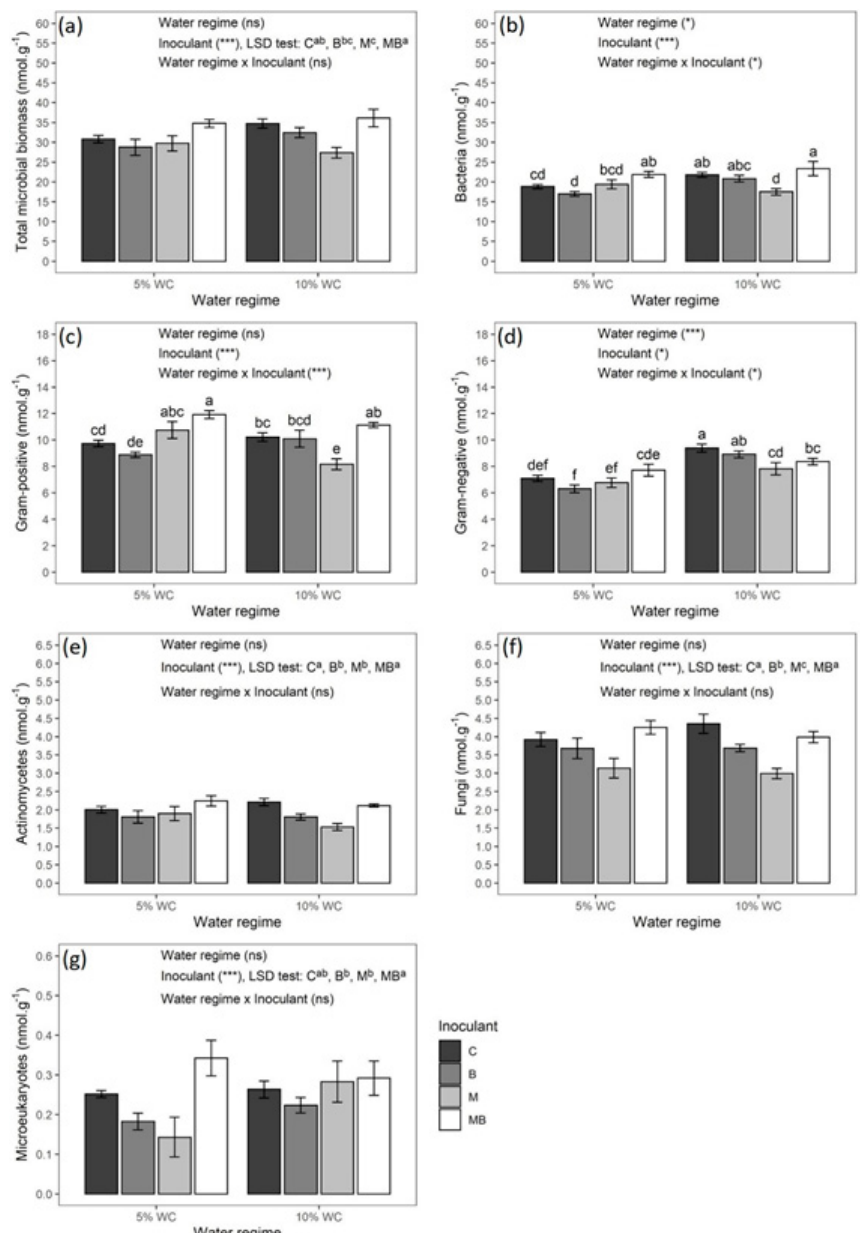
Figure 2. Mean ( ± SE) biomass of total microbes ( a ), bacteria ( b ), Gram-positive ( c ), Gram-negative ( d ), actinomycetes ( e ), fungi ( f ) and microeukaryotes ( g ) (nmol g − 1 ) in the rhizosphere soil of L. sativa under different water regimes. The significant effect of “inoculant type × water regime” is presented by the letters above the bars; bars topped by the same letter do not differ significantly. In the case of a single effect of the inoculum type, different superscript letters produced by LSD, denote significant differences (a: corresponds to the highest value, C = Control, B = B. subtilis , M = AMF, MB = AMF and B. subtilis ). (* p < 0.05, *** p < 0.001, ns: